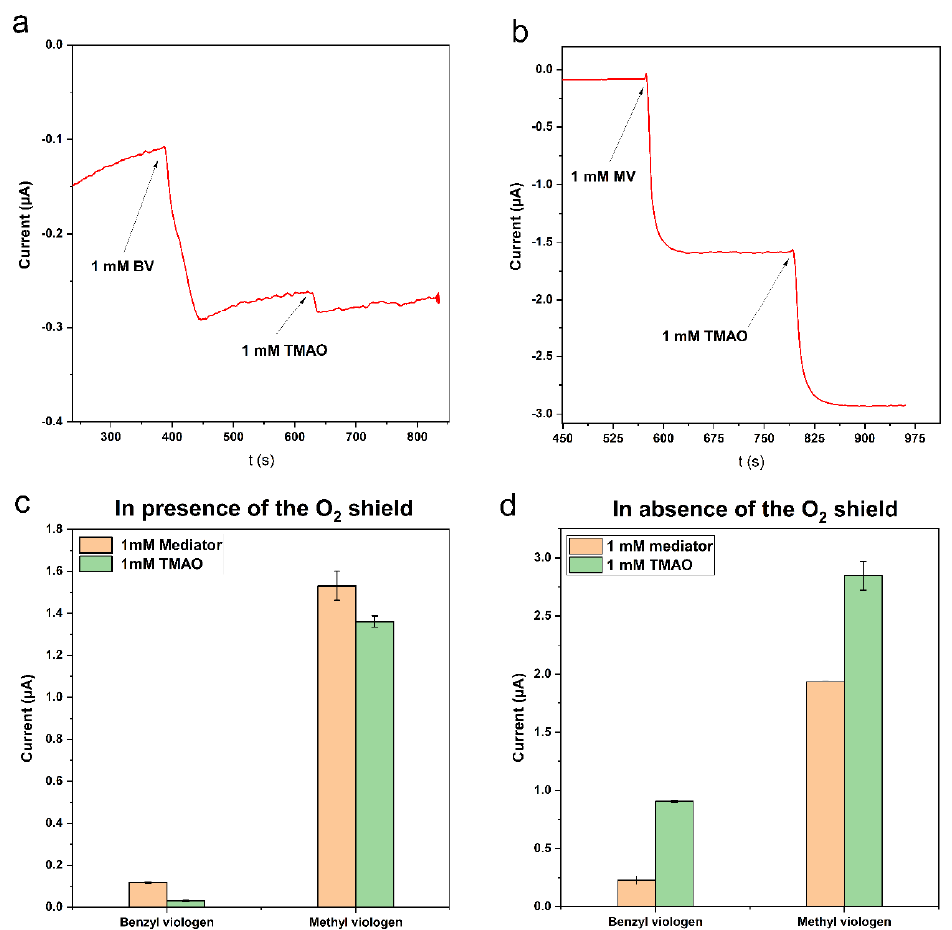
Figure 4. Comparison of the effect of BV and MV on TMAO biosensor response. Current response trace upon addition of 1 mM ( a ) BV and ( b ) MV followed by addition of 1 mM TMAO. Comparison of the mediator effect on the sensor response ( c ) with GOD/Cat membrane and ( d ) with GOD and Cat in solution. The TMAO biosensor used in these experiments was composed of a GCE modified with the TorA (5.9 nmol/cm 2 ) and the oxygen-scavenging membrane. Measurements were performed in Sörensen buffer pH 7, 3 mM glucose. The solution was stirred during measurements ( n = 3 electrodes, three measurements each) .